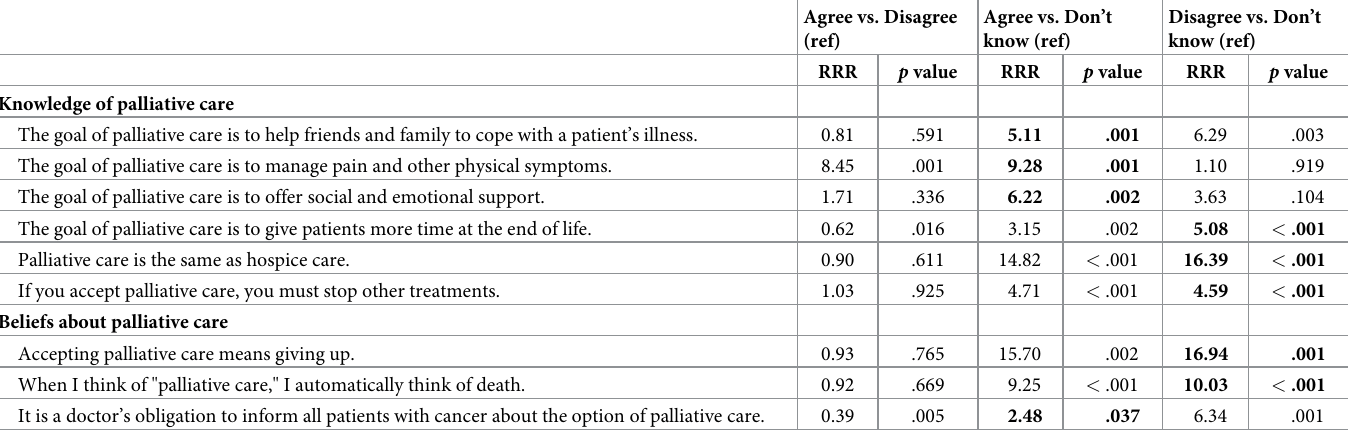
Table 3. Multinomial regressions with the degree of self-assessed awareness (know a lot versus know a little) about palliative care predicting the likelihood of a) agreeing versus disagreeing, b) agreeing versus responding “don’t know,” and c) disagreeing versus responding “don’t know” for knowledge and belief items. Agree vs. Disagree